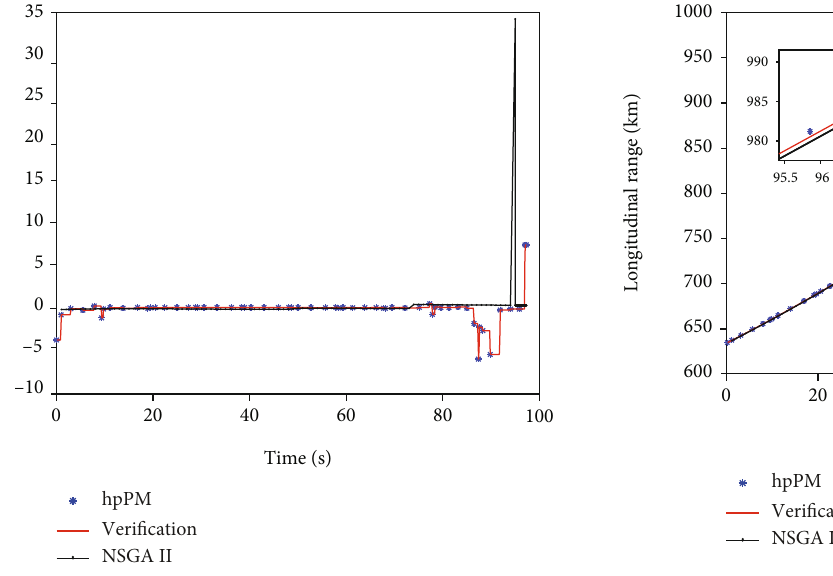
Figure 18: Change rate of attack angle.